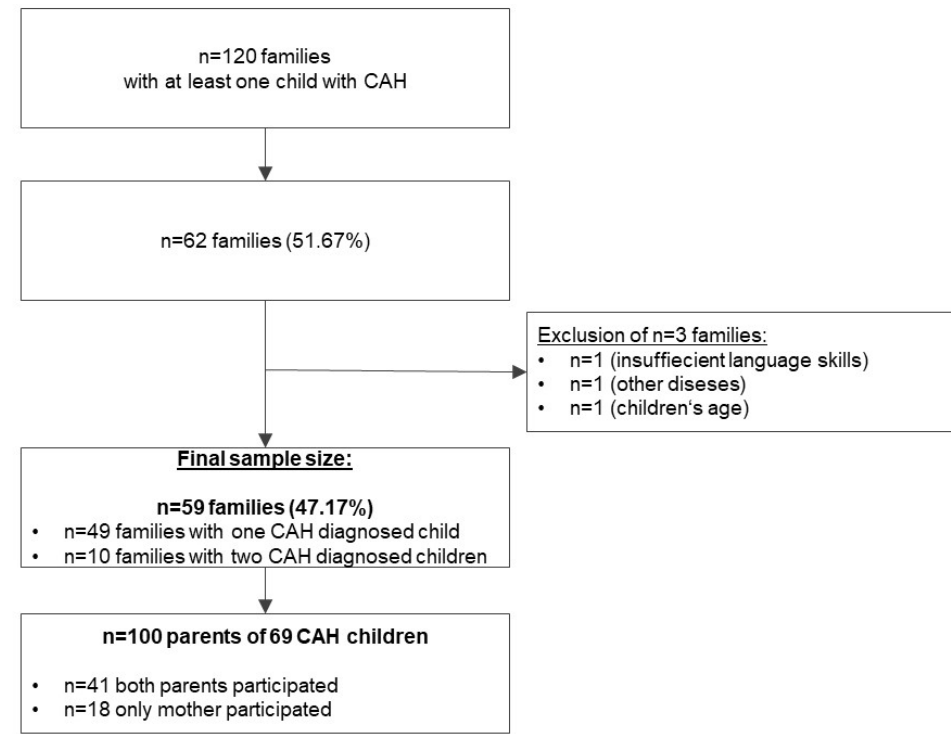
Figure 1. Flowchart of the recruiting process .